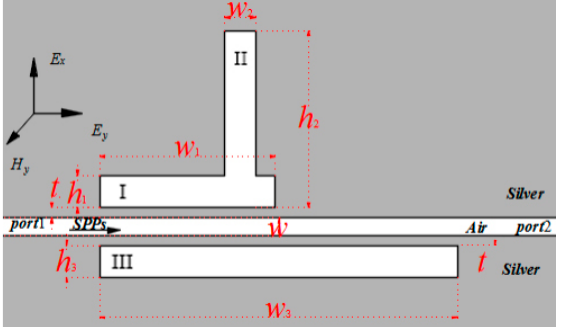
Figure 10. Structure diagram of MIM with three rectangular resonators after cavities I and II were partially combined.